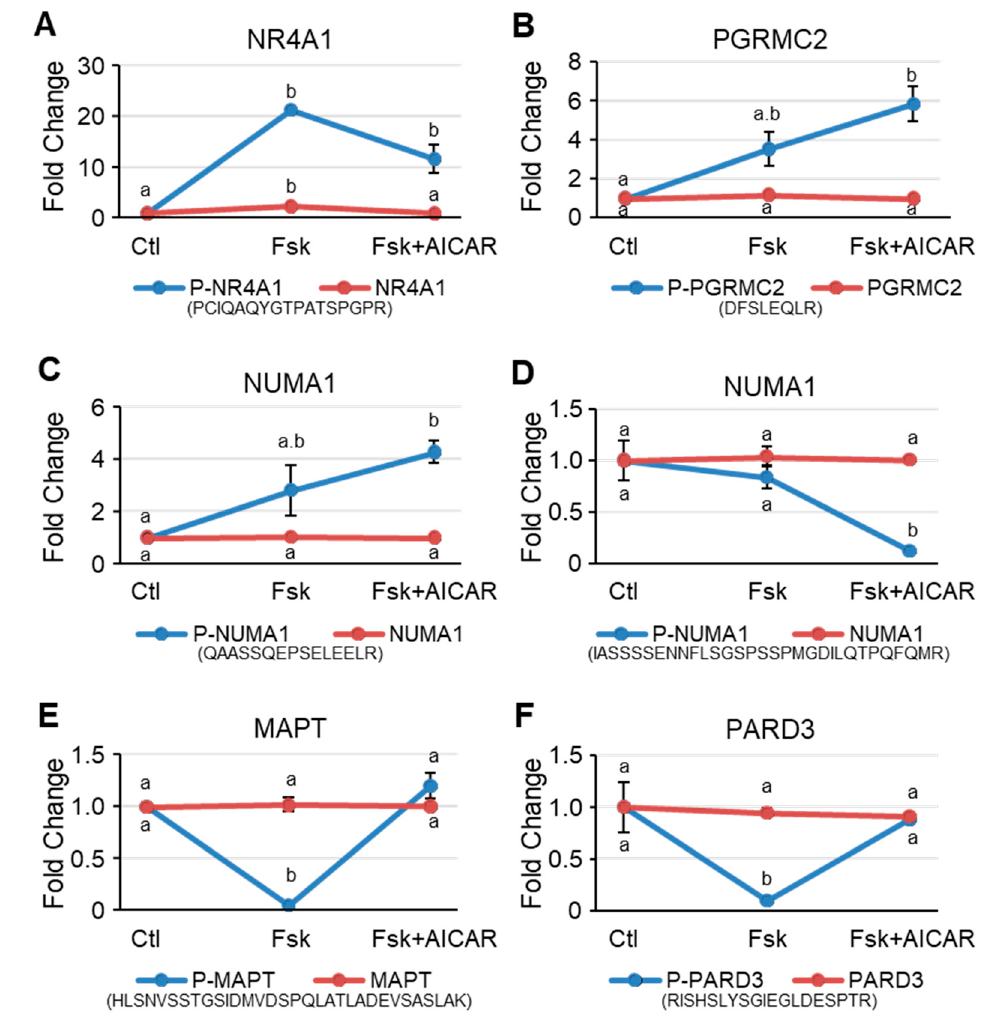
Figure 5. Representative proteins that are differentially phosphorylated in MA-10 Leydig cells in response to Forskolin and to Forskolin+AICAR. Intensity plots of representative phosphoproteins (blue lines) and total proteins (red lines). Ctl, DMSO-treated cells; Fsk, Forskolin-treated cells; Fsk+AICAR, cells treated with Forskolin and AICAR. Results are shown as Fold Change compared to the control. Results are the mean of three individual experiments +/ − SEM. The phosphopeptide sequence is shown beneath the graph. For a given protein, different letters indicate a statistically significant difference between treatment groups ( p < 0.05).